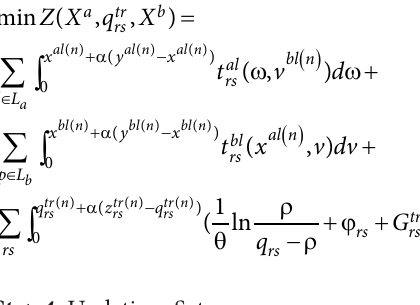
Table 1. Th e price per kilometre for train is assumed to